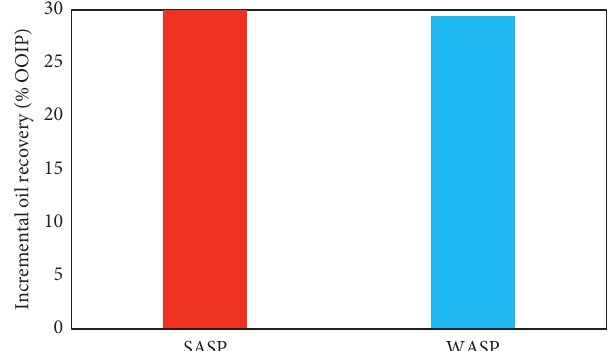
Figure 10: Incremental oil recovery